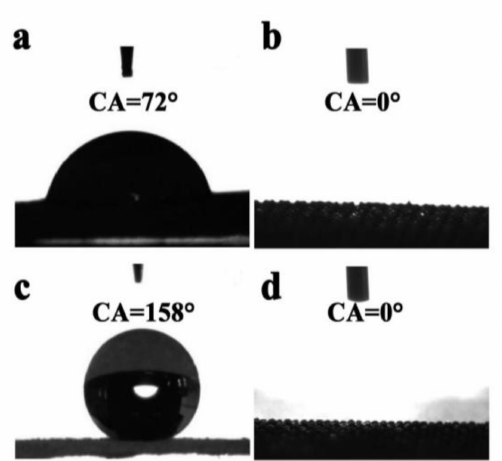
Figure 5. WCAs of the pristine Ti mesh ( a ), the etched Ti mesh ( b ), the FOTS-modified Ti mesh ( c ) and the UV-irradiated superhydrophilic mesh ( d